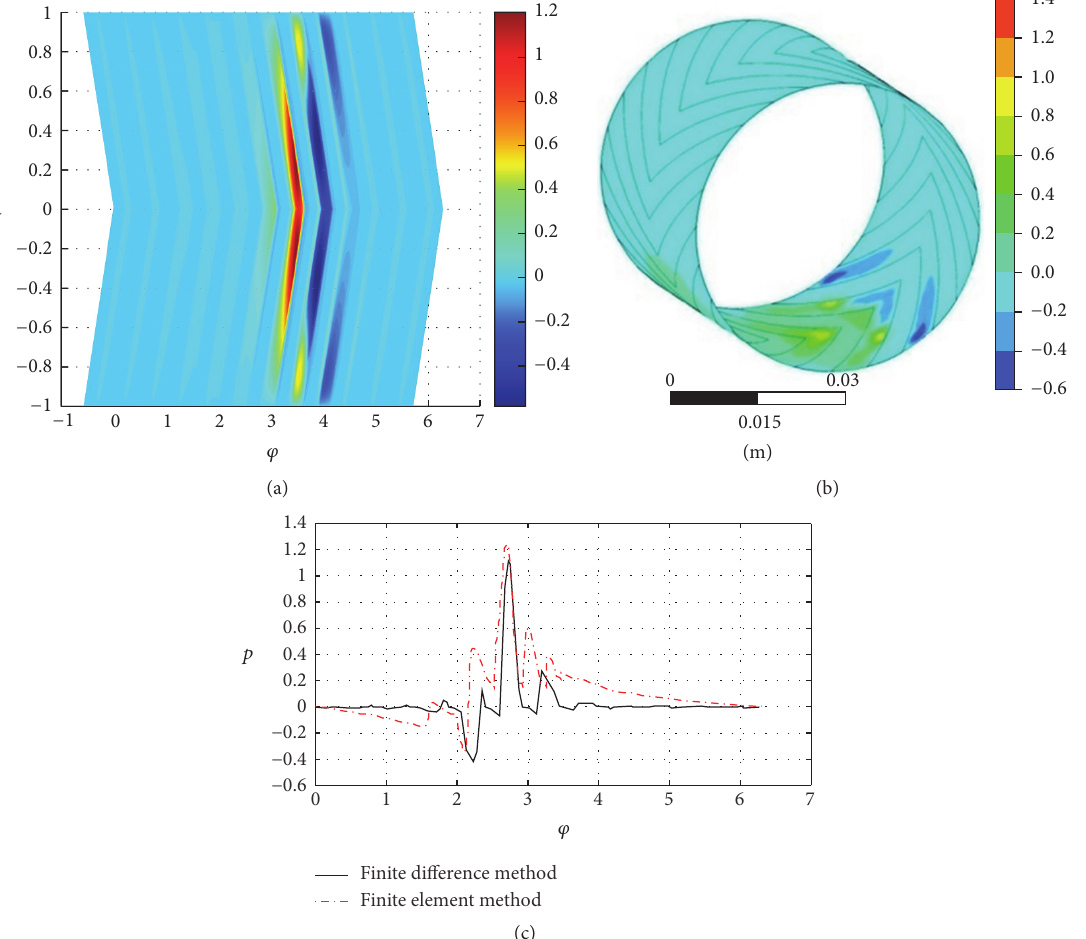
Figure 9: Nondimensional pressure nephogram of the HGGJB by (a) the finite difference method and (b) the finite element method; (c) the corresponding circumferential pressure distribution curve of the cross-section of HGGJB by the finite difference method and the finite element method.